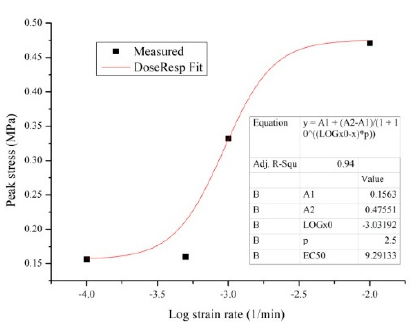
Figure 16. Strength master curve [20].